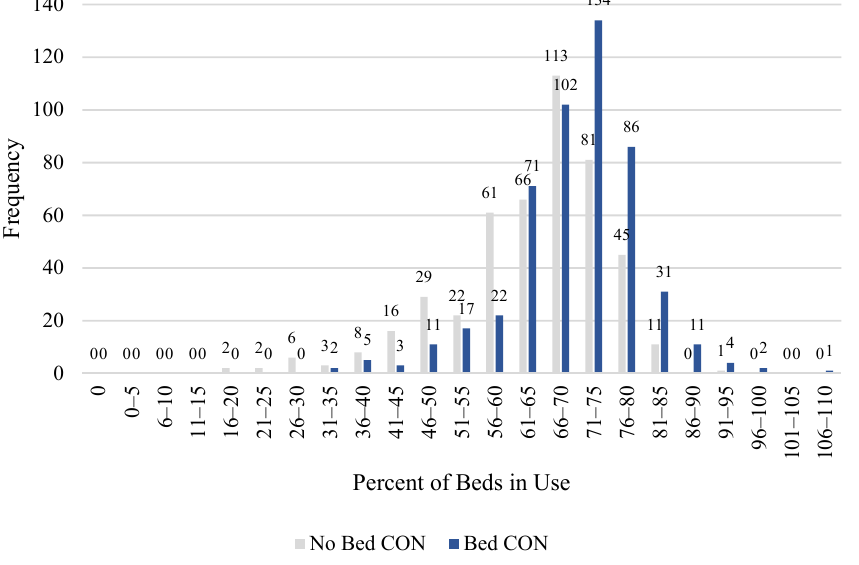
Figure 7. Frequency of Hospital Bed Usage Rates, by CON Requirement. Source: Authors’ calcula- tions, COVID-19 Reported Patient Impact and Hospital Capacity by State Timeseries (2021). Table 2. Descriptive Statistics, Observations by State and Month, Bed CON and Non-Bed CON States.